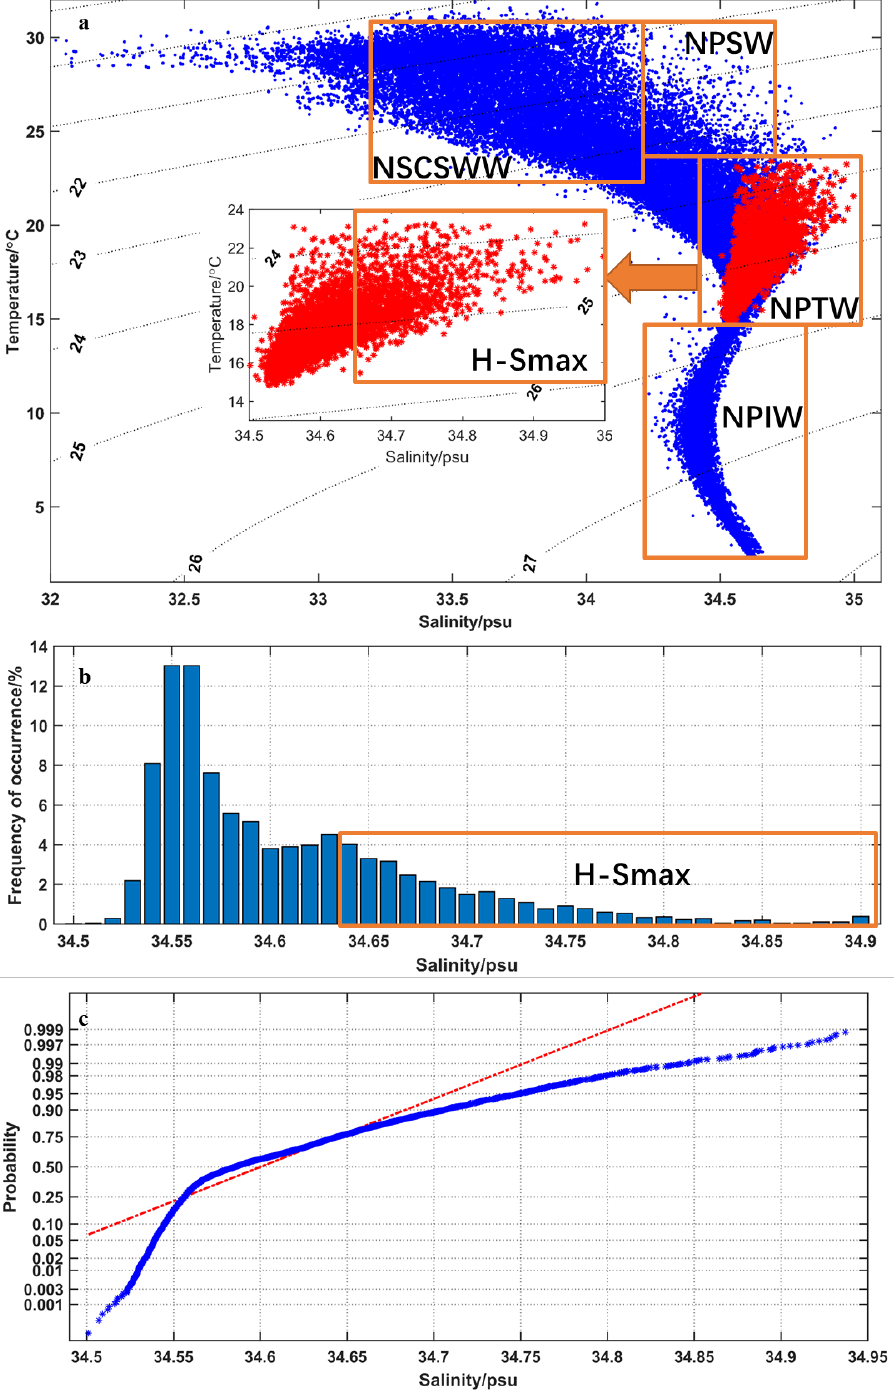
Figure 7. ( a ) T-S diagrams from Argo vertical profiles (2006 – 2019) in the NSCS. The dashed curves are isopycnals with σ θ values (kg/m 3 ) denoted. The blue dots and red dots stand for all Argo profiles and the salinity-maximum data, respectively. The definitions of different water masses were based on [3,9,13,27 – 29]. NPTW: North Pacific Tropical Water; NPIW: low-salinity North Pacific Intermediate Water; NPSW: North Pacific Surface Water; NSCSWW: NSCS Warm Water; H-Smax: anomalously high subsurface salinity water in the NSCS. ( b ) The frequency histogram of the salinity-maximum data by salinity. ( c ) The normal probability plot of the salinity-maximum data by salinity.